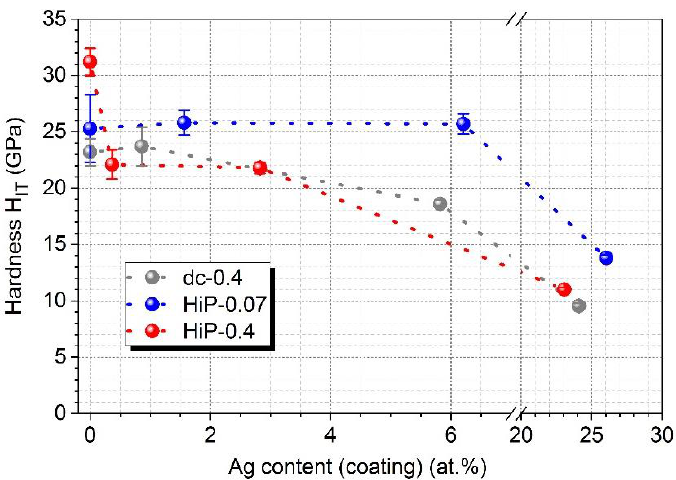
Figure 10. Indentation hardness H IT vs. Ag content of the MoN-Ag coatings. The influence of a substrate bias voltage on hardness and Ag content of MoN-Ag coatings is presented in Figure 11. The process HiP-0.4 (MoAg35 target) was used as a base for having the maximum i peak and thus ionization of the sputtered atoms. Obviously,